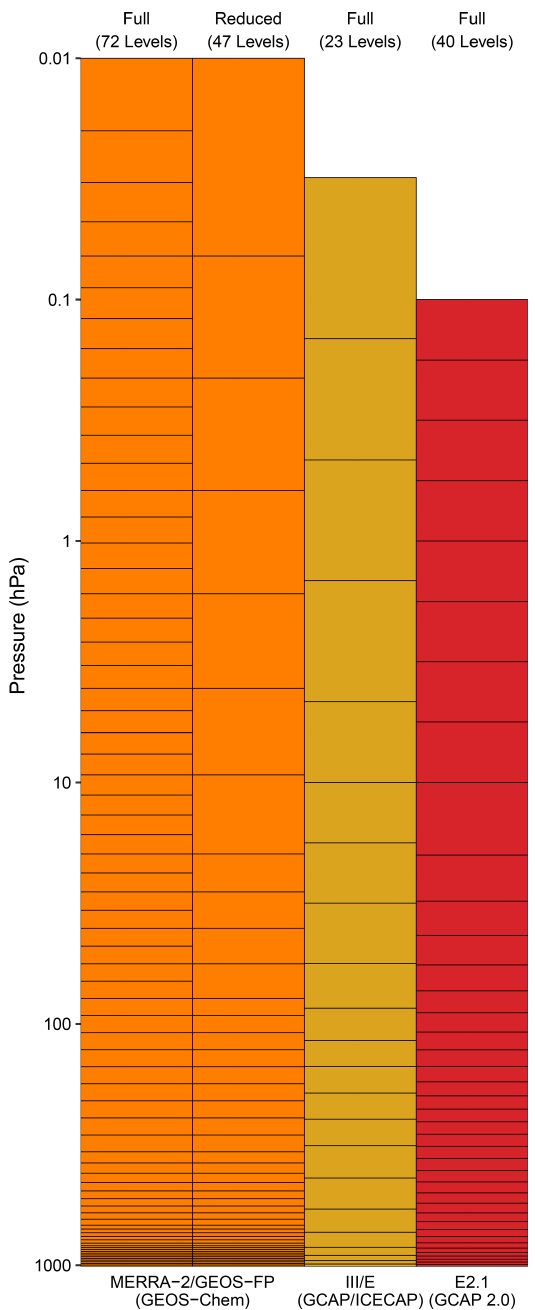
Figure 1. Comparison of the vertical resolutions of GEOS-Chem driven by the MERRA-2 or GEOS-FP reanalyses (full and the re- duced stratosphere; orange), the original GCAP driven by Model III or ICECAP driven by ModelE (yellow), and GCAP 2.0 driven by E2.1